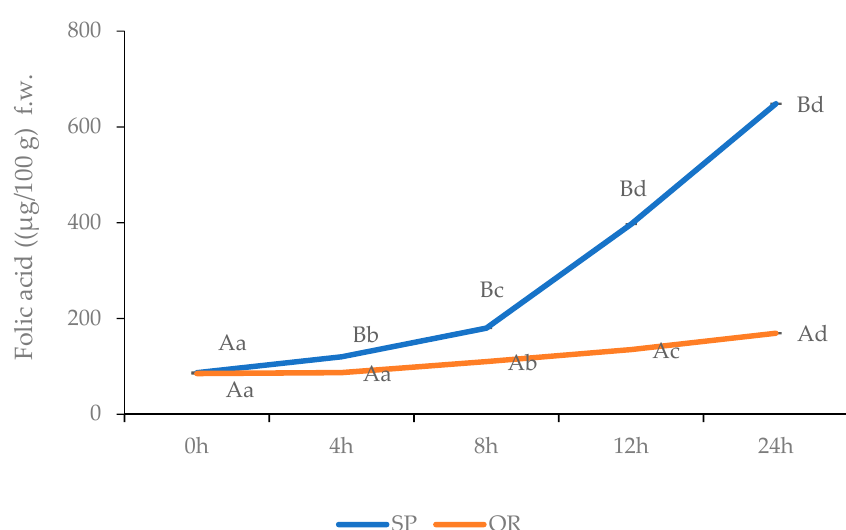
Figure 2. SP and OR folic acid content. Small letters in common indicate no significant di ff erences between OR and SP samples withdrawn at di ff erent moments; Big di ff erent letters indicate significant di ff erences between SP and OR samples withdrawn at the same moment.